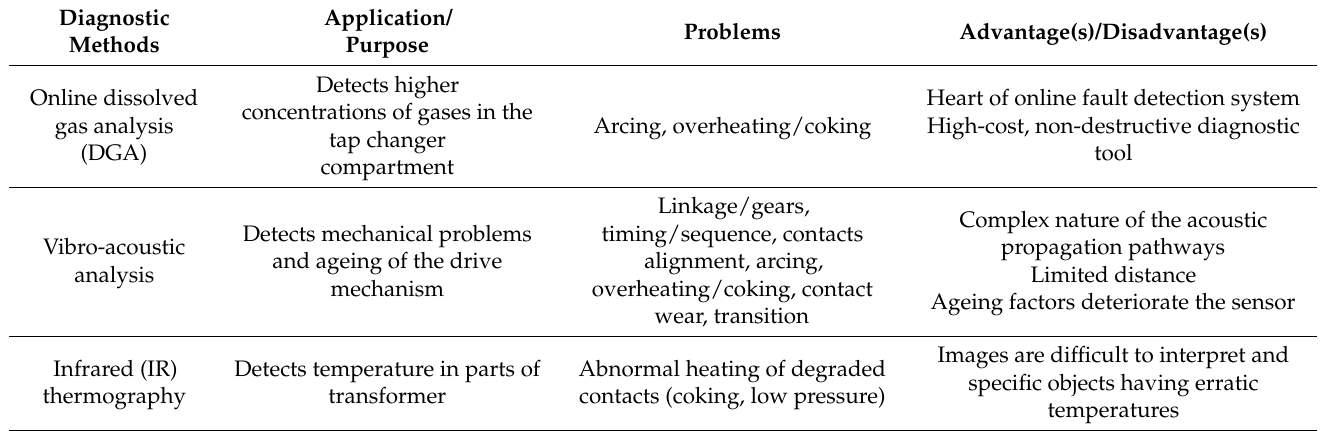
Table 7. Summary of online condition monitoring